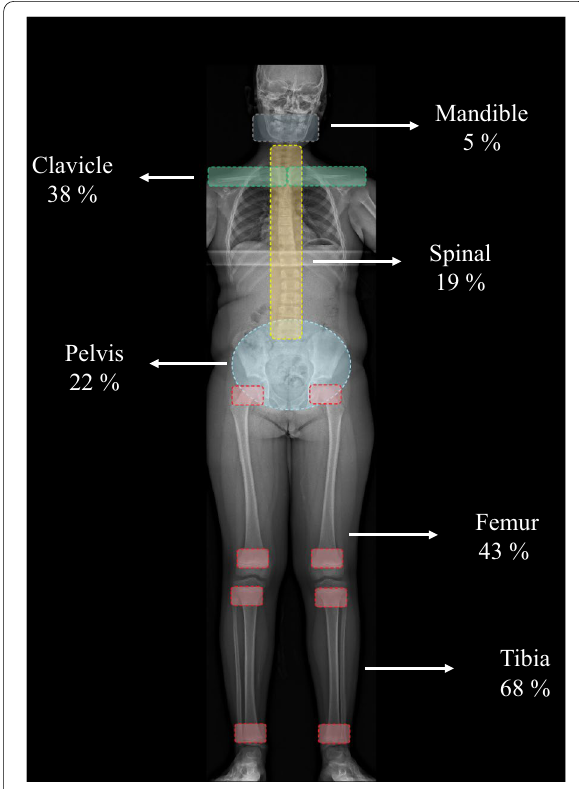
Fig. 11 The most common affected bones in CNO and the percent of patients with each type of lesion site. Adapted from